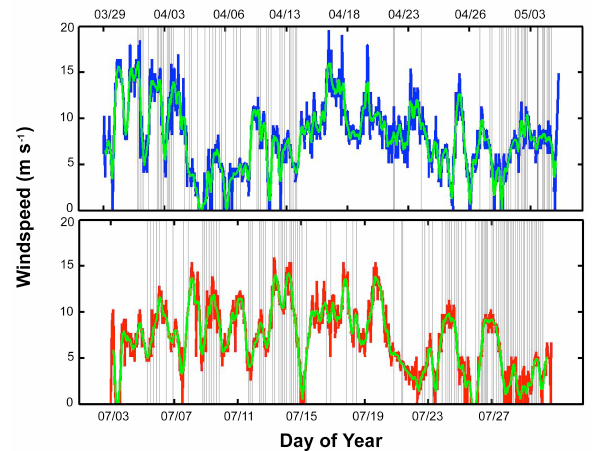
Figure 3. Surface windspeed observations (m s -1 ) from the USCGC Healy for both the spring Fig. 3. Surface windspeed observations (ms − 1 ) from the USCGC (top plot) and summer (bottom plot) 2008 BEST cruises. In each plot, the original hourly Healy for both the spring (top plot) and summer (bottom plot) 2008 wind data is shown in blue (spring) and red (summer) with the 6-hour running mean shown in BEST cruises. In each plot, the original hourly wind data is shown green. The grey lines indicate times of CTD casts. in blue (spring) and red (summer) with the 6-hour running mean shown in green. The grey lines indicate times of CTD